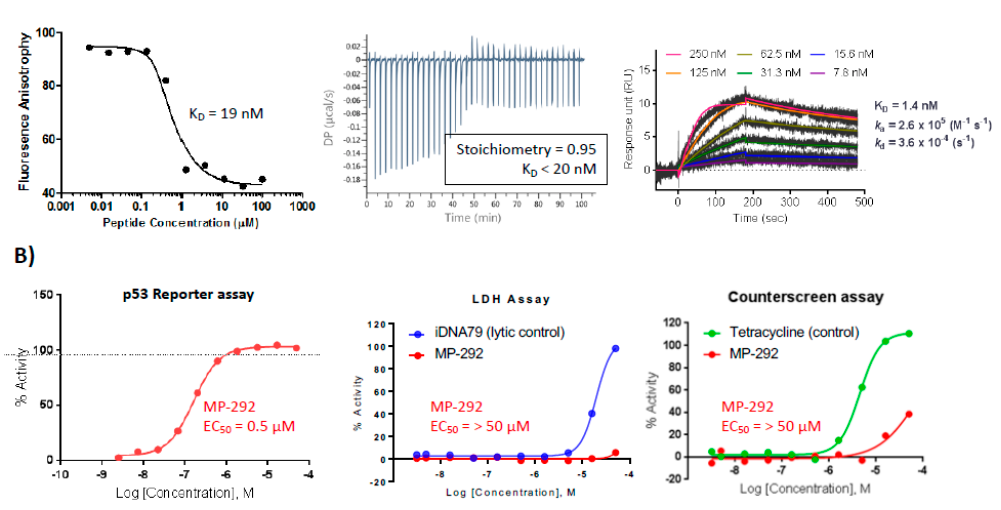
Figure 2. MP-292 is a bona fide Mdm2 binder with on-target cellular activity. ( A ) MP-292 binds to recombinant Mdm2 in a host of biophysical assays, including competitive fluorescence polarization (left panel), isothermal titration calorimetry (middle panel), and surface plasmon resonance (right panel). ( B ) MP-292 shows cellular activity in a β -lactamase-based p53 reporter assay (left panel) but not in counterscreenassays, suchas thoseprobingfor disruptionin membraneintegrity (lactatedehydrogenase release, middle panel), nor a β -lactamase based reporter-assay driven from a tetracycline-dependent promoter (p53 independent, right panel).